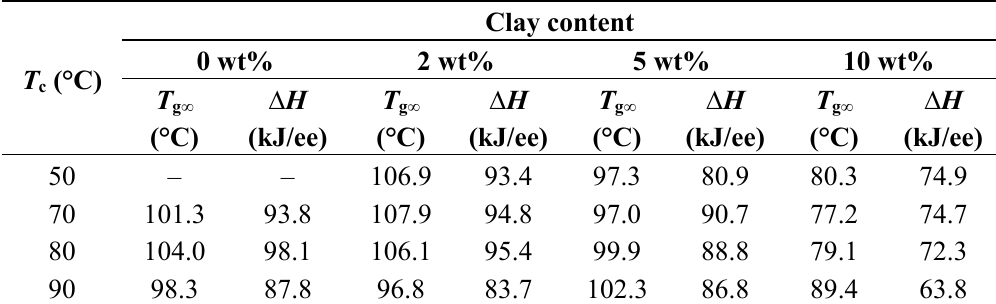
Table 1. DSC results for the isothermal cure of nanocomposites with HBP: T is the glass transition temperature of the fully cured nanocomposite and temperature; T g ∞ ∆ H is the total heat of the